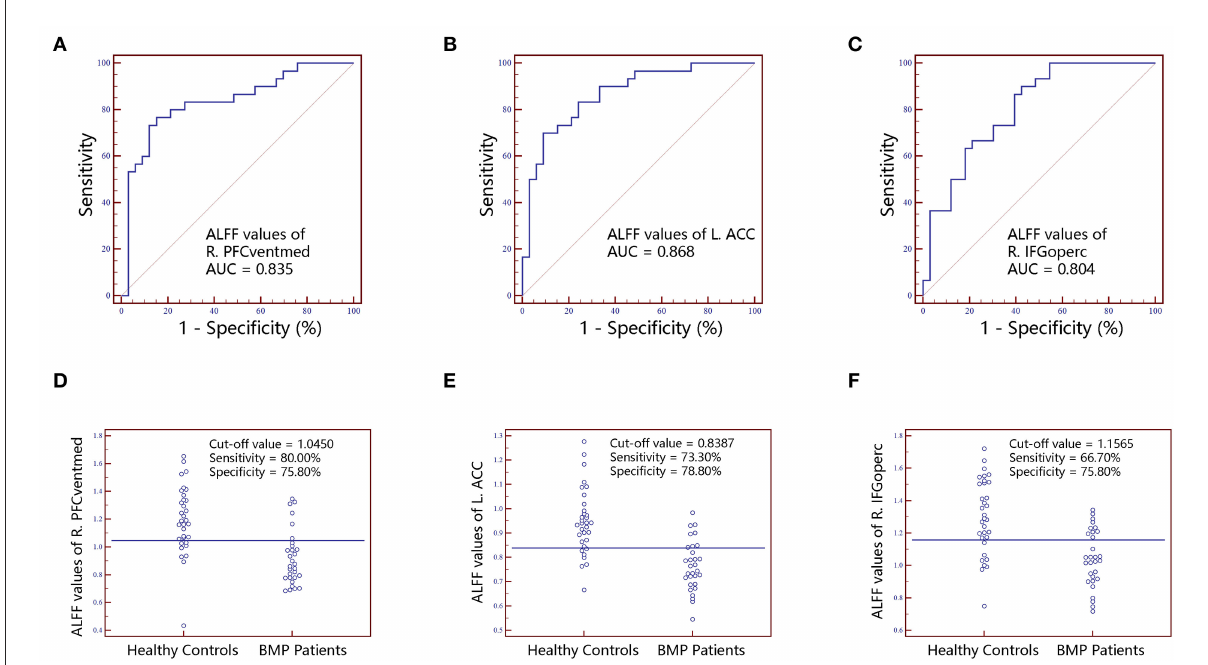
FIGURE3 The classification performance of ALFF values extracted from individual brain regions identified by intergroup comparison. The top row are receiver operating characteristic curves for R.PFCventmed (A) , L.ACC (B) and R.IFGoperc (C) . The bottom row are interactive dot diagrams for R.PFCventmed (D) , L.ACC (E) and R.IFGoperc (F) . ALFF, amplitude of low-frequency fluctuations; ACC, anterior cingulate cortex; AUC, areas under receiver operating characteristic curve; IFGoperc, inferior frontal gyrus, opercular part; PFCventmed, superior frontal gyrus, medial orbital; R, right; L, left.